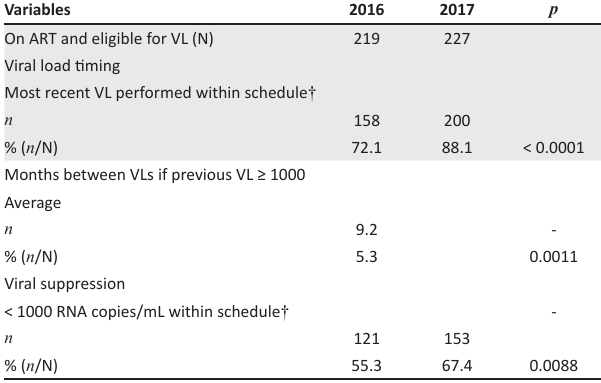
TABLE 4: Viral load data.